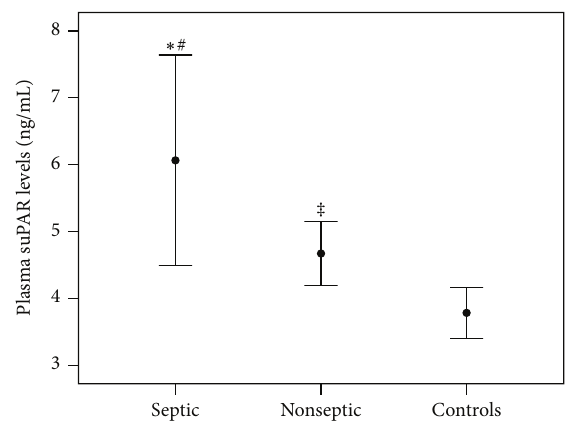
Figure 1: Plasma suPAR levels in septic, and nonseptic neonates, and controls. The bars represent mean (95% confidence interval for mean) of suPAR concentrations on admission. ∗ 𝑃 ≤ 0.001 , ‡ 𝑃 ≤ 0.05 compared with controls; # 𝑃 < 0.05 compared with nonseptic neonates.